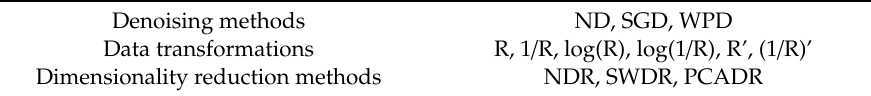
Table 2. Pretreatment methods used in this